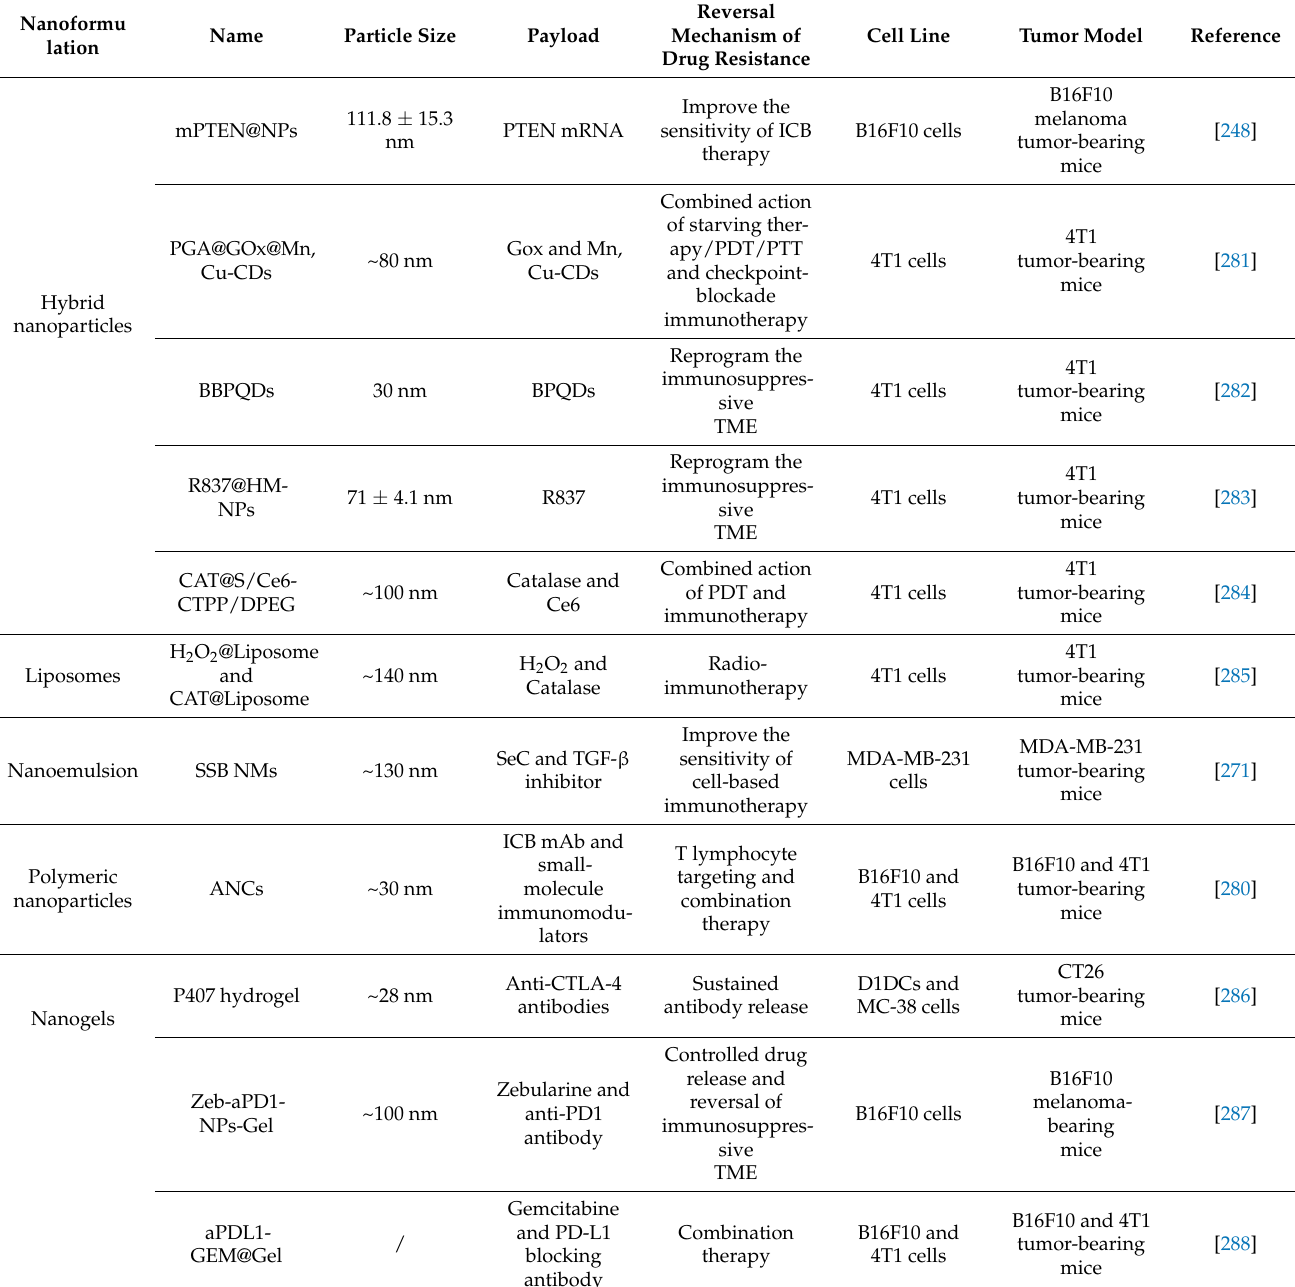
Table 4. Recent advances in nanomedicines for overcoming resistance to